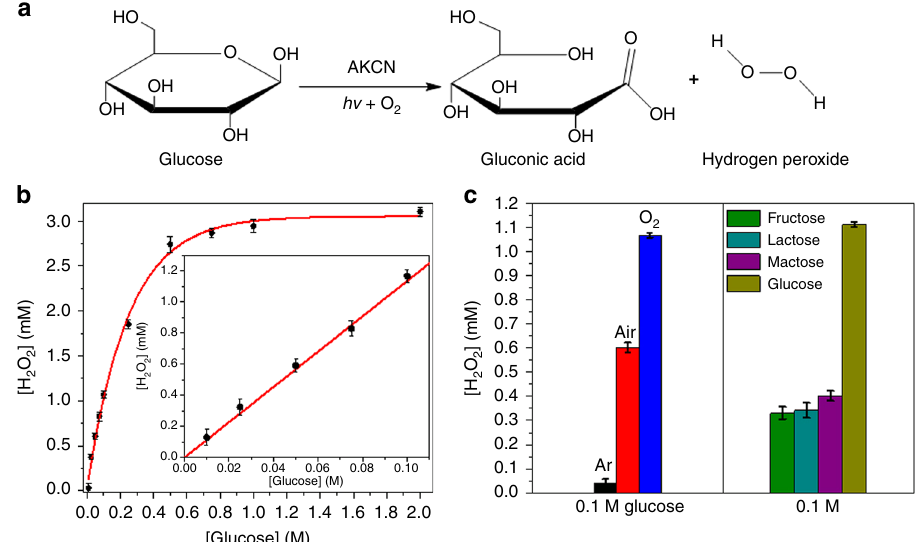
Fig. 5 Photocatalytic aerobic oxidation of glucose with the concurrent production of H 2 O 2 . a Scheme of GOx-like reaction of AKCN (photoenzyme). b H 2 O 2 production as a function of glucose concentration (inset: enlarged plot in the linear region) in the phosphate buffer (0.1 M, pH 7) suspension of photoenzyme (0.5 g L − 1 ) under visible light illumination ( λ ≥ 420 nm), T = 25 o C. c H 2 O 2 generated by AKCN photoenzyme in the presence of different kinds of saturated gas (0.1 M glucose) and carbohydrate substrate (0.1 M). The error bar represents the standard deviation from the repeated experiment after three times. Source data are provided as a Source Data fi le the photocatalytic oxidation of glucose was negligibly small phototransformed to gluconic acid on AKCN as illustrated in (2 µmol), compared with that of H 2 O 2 (0.8 mM, in the O 2 -satu- Fig. 5a. The concentration of H 2 O 2 was determined by the col- rated glucose buffer solution (1 M) after 1 h irradiation). This orimetric N,N-diethyl-1,4-phenylene-diamine sulfate (DPD) indicates that the photocatalytic mineralization of glucose is method (DPD oxidized by H 2 O 2 and POD), which exhibited a prohibited in the present condition and glucose is selectively good linearity up to 1.5 mM H 2 O 2 (Supplementary Figure 10). NATURE COMMUNICATIONS| (2019) 10:940